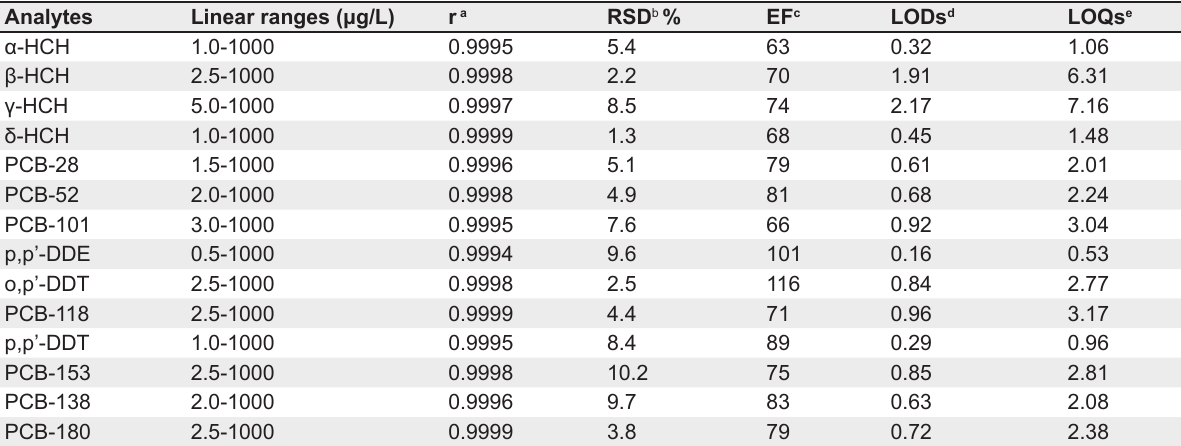
Table 4. Quantitative results of DLLME and GC-ECD of OCPs and PCBs.